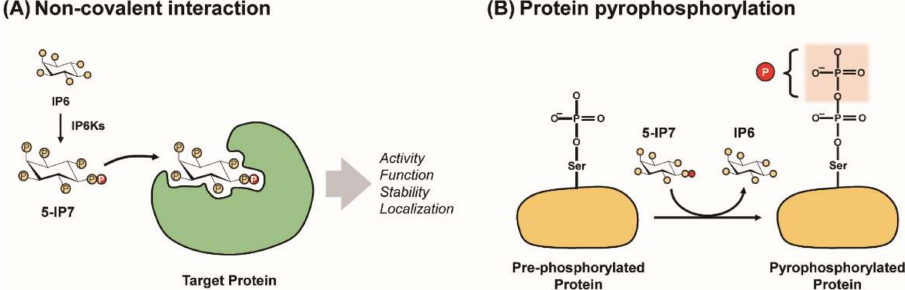
Figure 2. Modes of PP-IPs’ signaling action. PP-IPs can modulate characteristics of target proteins (e.g., activity, function, localization, and stability) via either the allosteric PP-IP − protein interaction ( A ) or protein pyrophosphorylation ( B